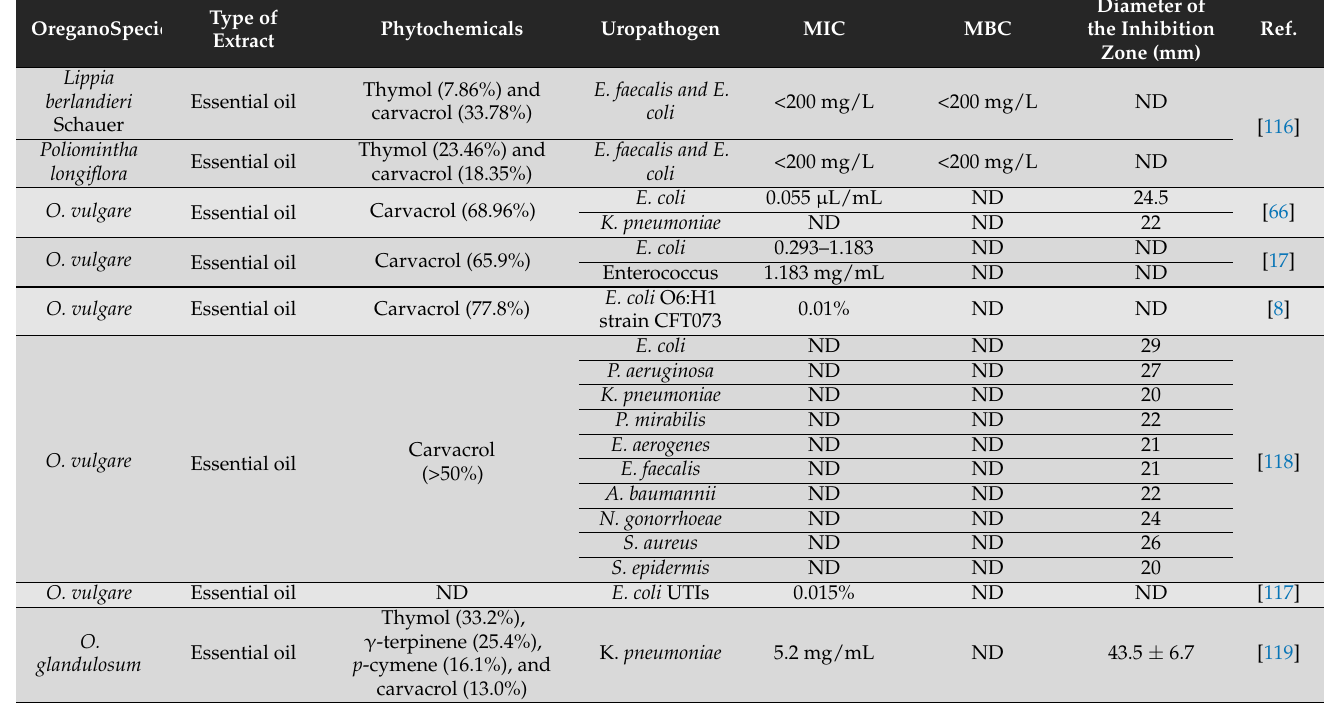
Table 4. Antimicrobial activity of oregano